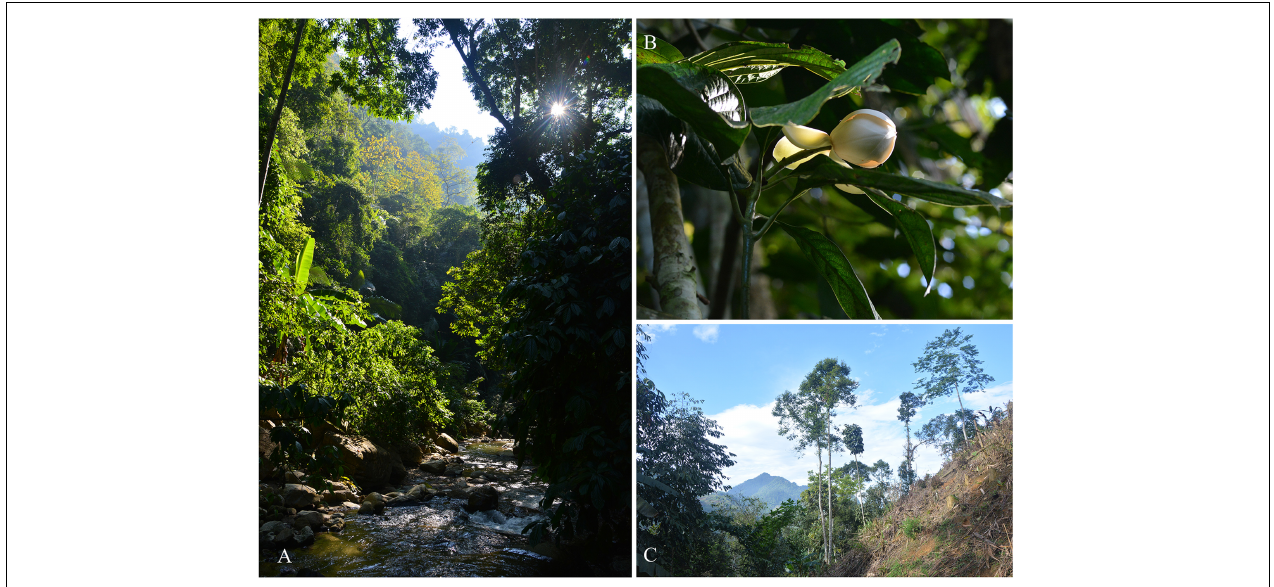
FIGURE 1 | (A) The habitant of Magnolia fistulosa in QSH (Qingshui River, Gejiu). (B) The flower of M. fistulosa . (C) Habitat destruction of M. fistulosa in LB (Longbao Village,